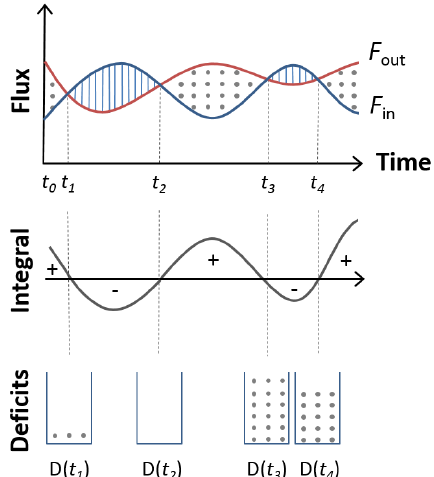
Figure 1. Conceptual illustration of the algorithm for calculat- ing the root zone storage capacity S R . The shaded areas repre- sent the accumulated differences A that are positive when outflow F out > inflow F in , and negative when F out <F in . Moisture deficit D is increased by positive A and decreased by negative A . Note that D never becomes